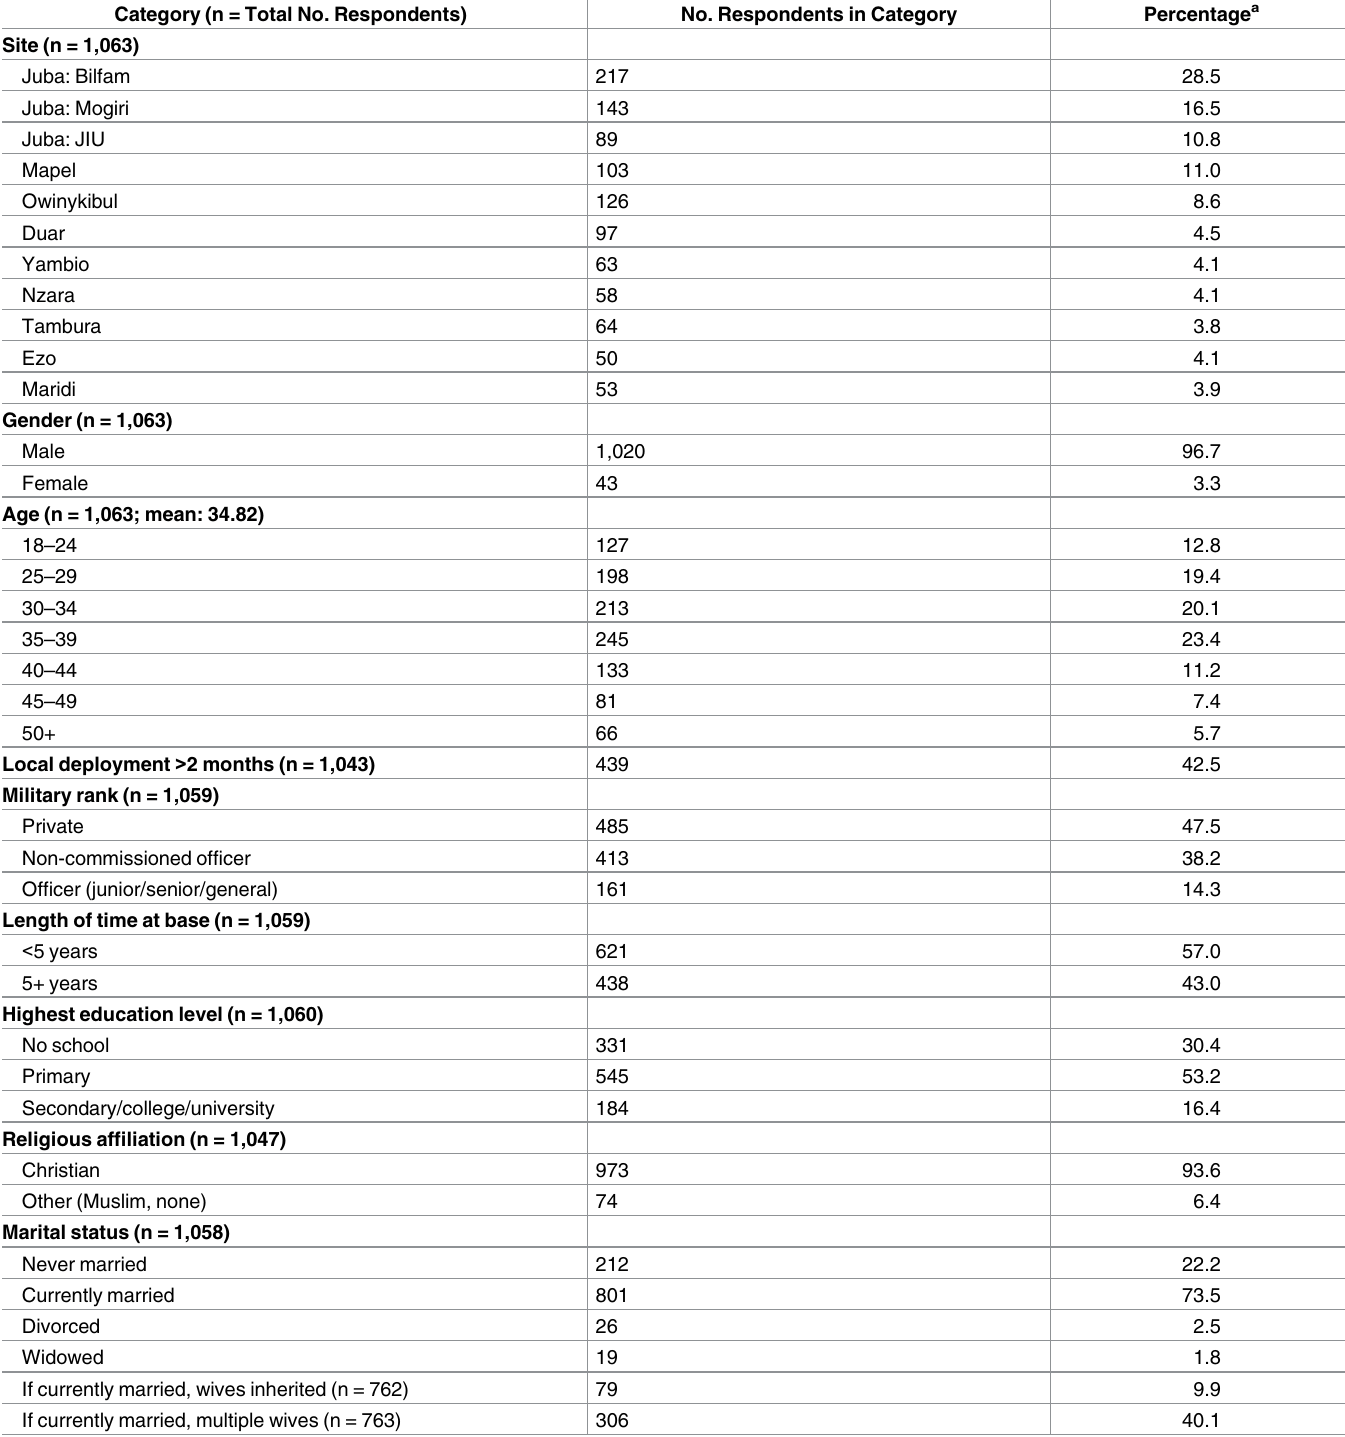
Table 1. Demographics of SPLA survey